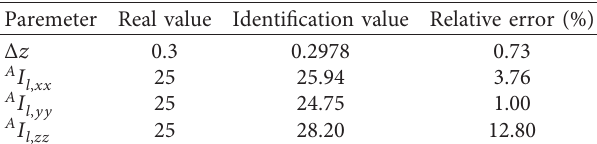
Figure 5: Identification results of load dynamics parameters. (a) The identification value of Δ z . (b) The identification value of A I identification value of A I l,yy . (d) The identification value of A I l,zz . Table 3: Real and identification inertia parameters of the payload. Paremeter Real value Identification value Relative error